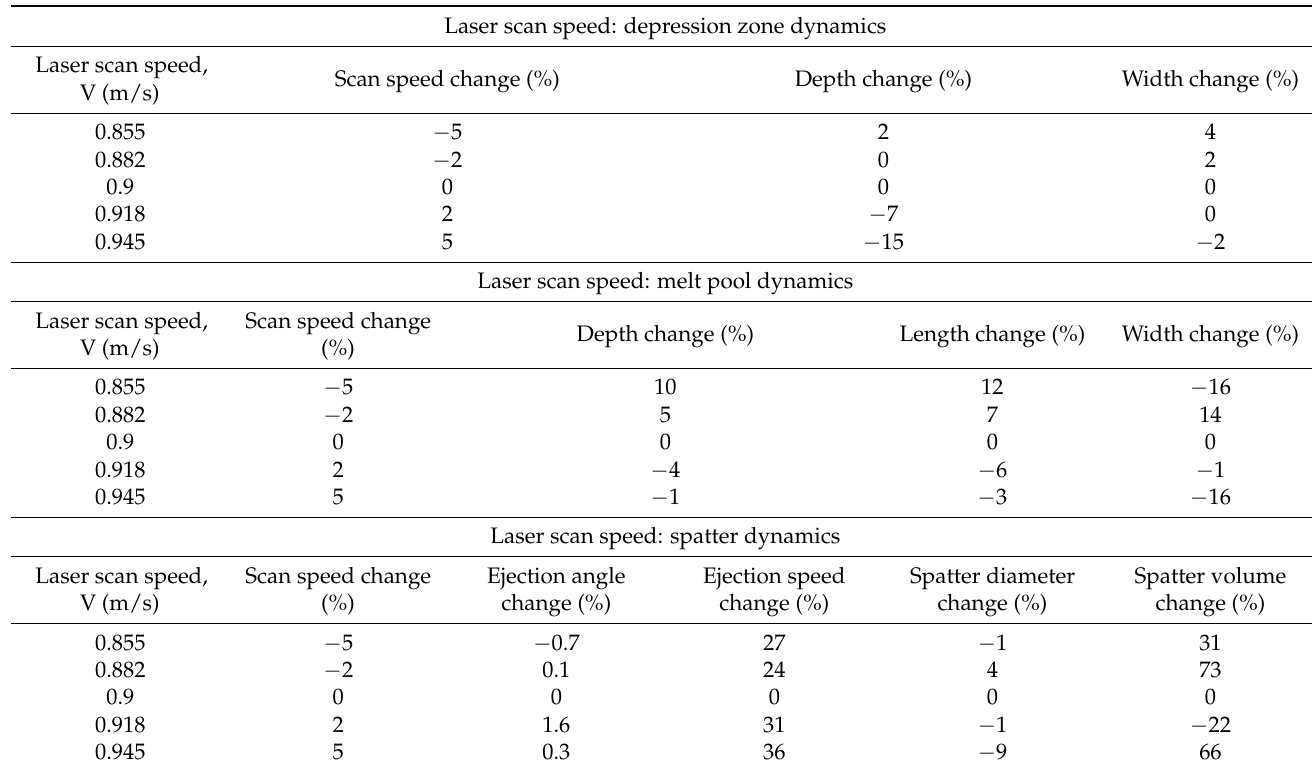
Table 5. Percent change in SLM dynamics induced by variations in the laser scan speed. Laser scan speed: depression zone